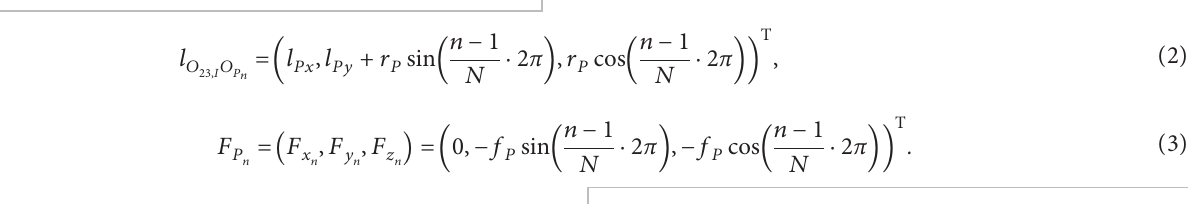
Figure 2. An annular base is mounted on the tip of the elevation part and thrusters are arranged in a uniform se- quence on the base.